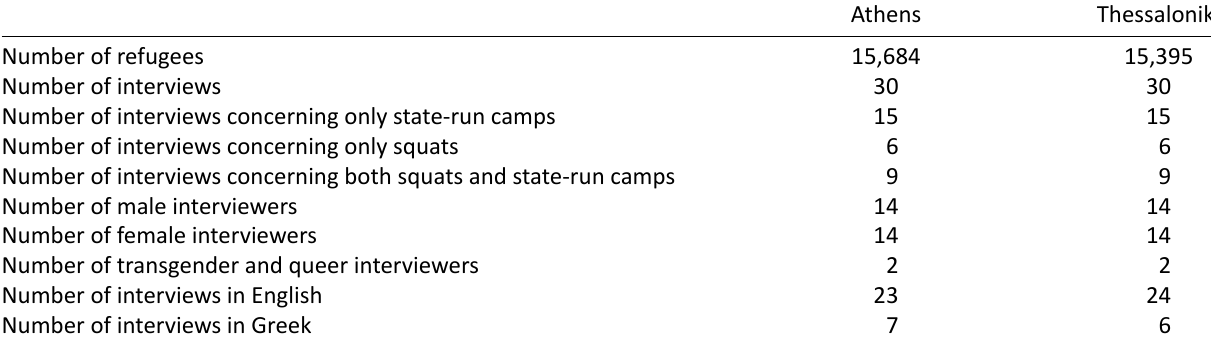
Table 1. Interviews